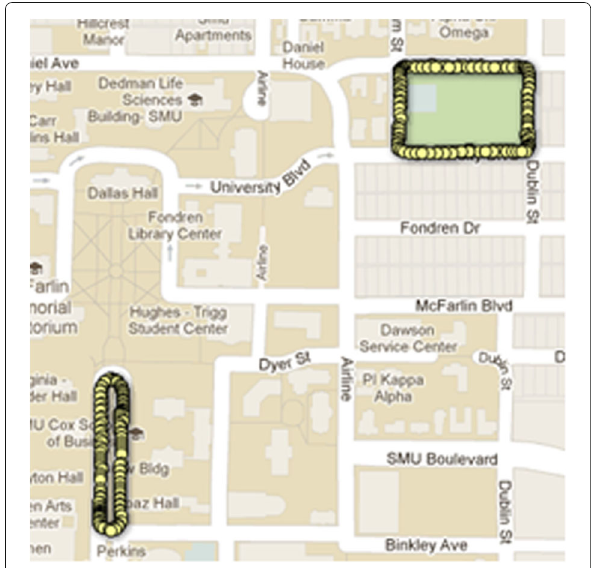
Fig. 11 Experiment locations. A screen shot of the Google map shows an experiment location